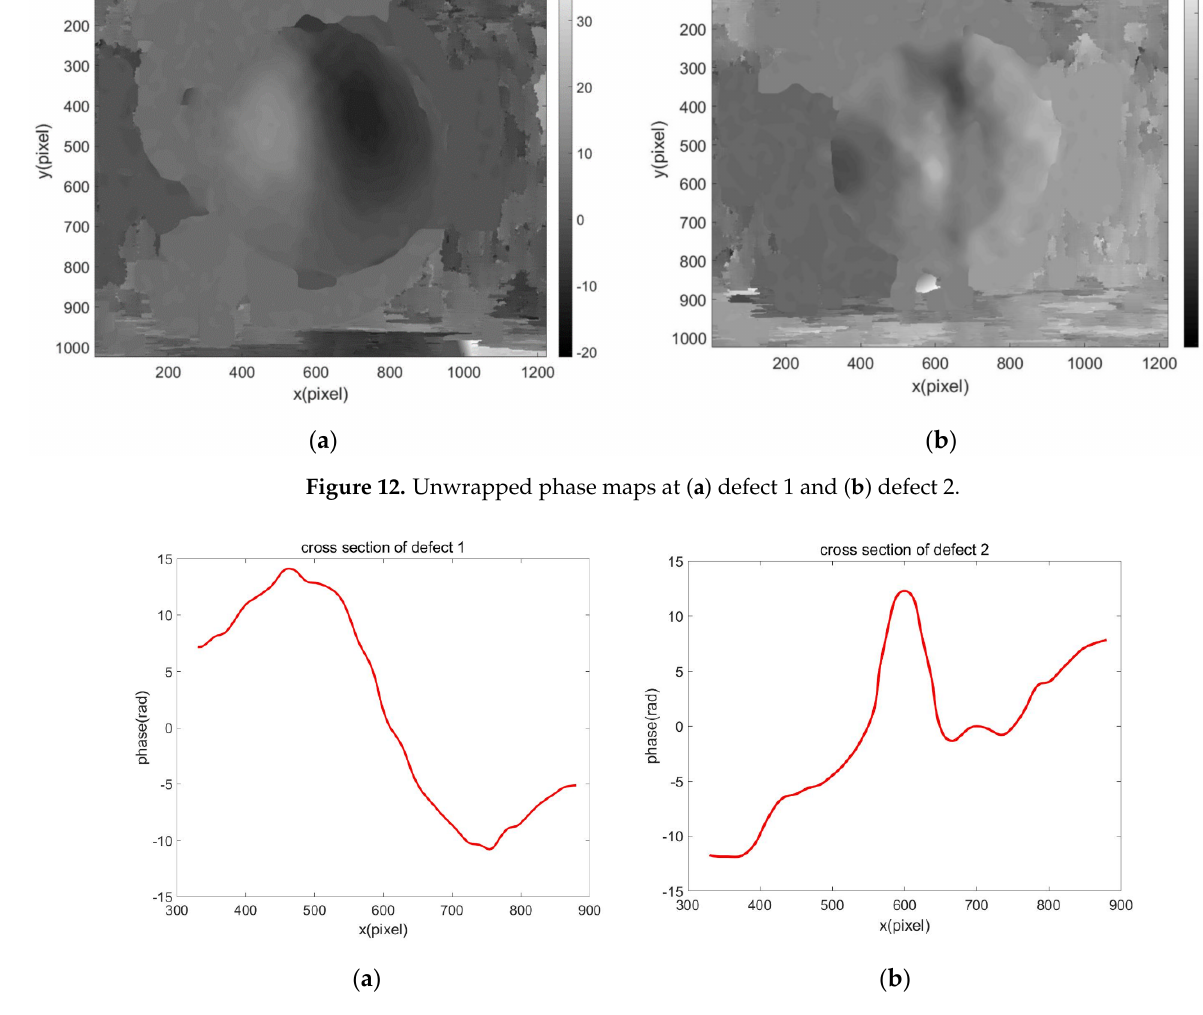
Figure 13. Cross-section profiles; ( a ) defect 1 ( b ) defect 2.